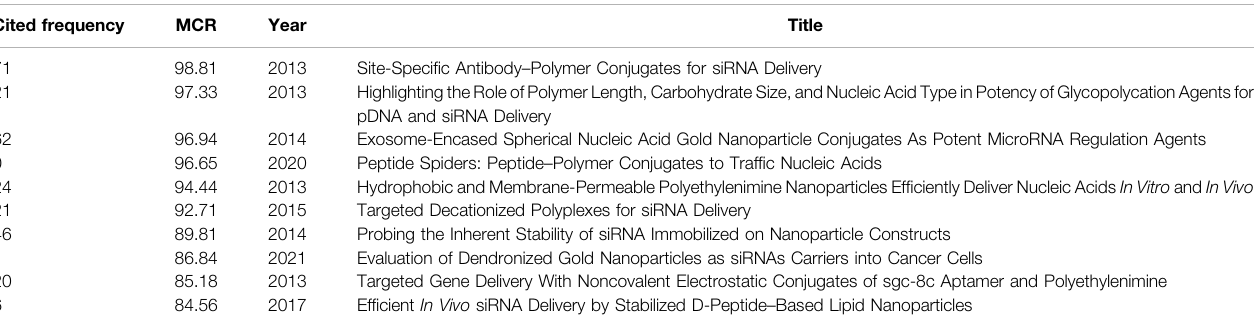
TABLE 2 | Top 10 original studies with the highest modularity change rate (MCR) from 2011 to